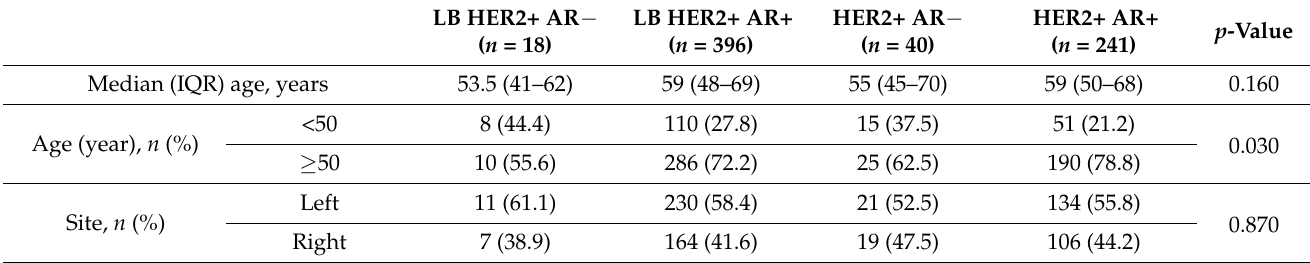
Table 4. Clinico-pathological data of 695 patients with HER2-positive breast cancer based on IHC